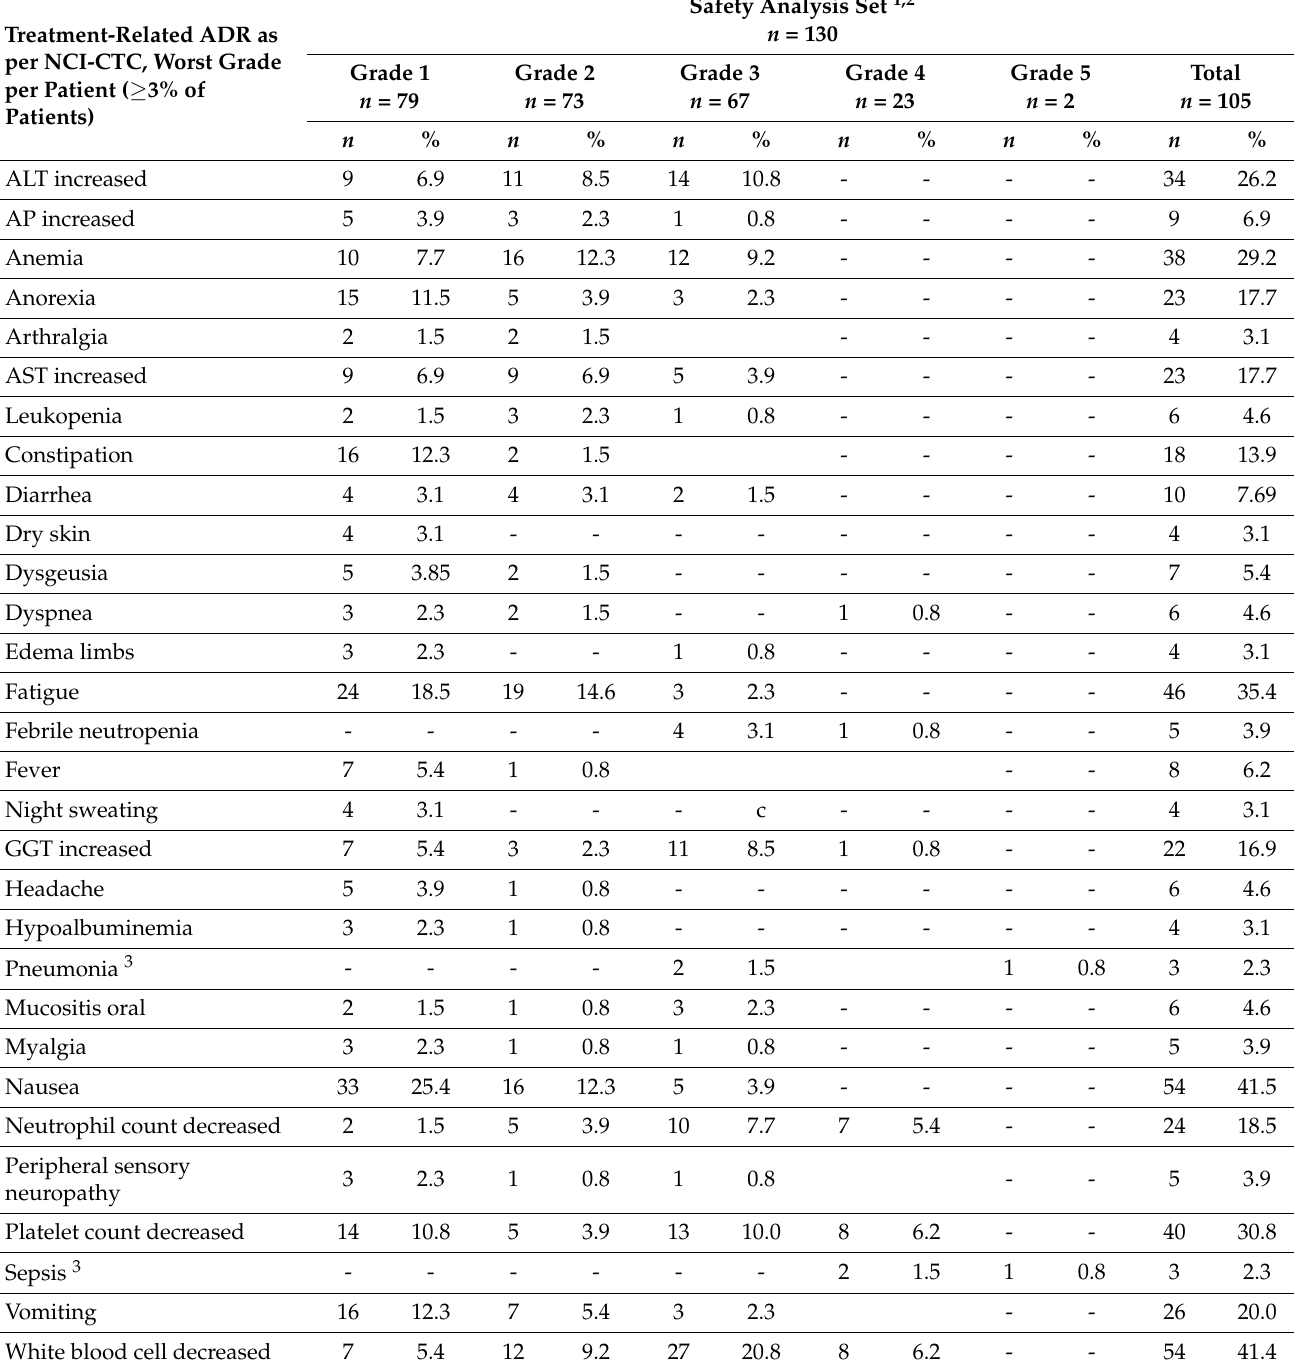
Table 5. Treatment-related adverse drug reactions (ADRs) in at least ≥ 3% of patients and all grade-5 ADRs as reported by the investigators (all treated